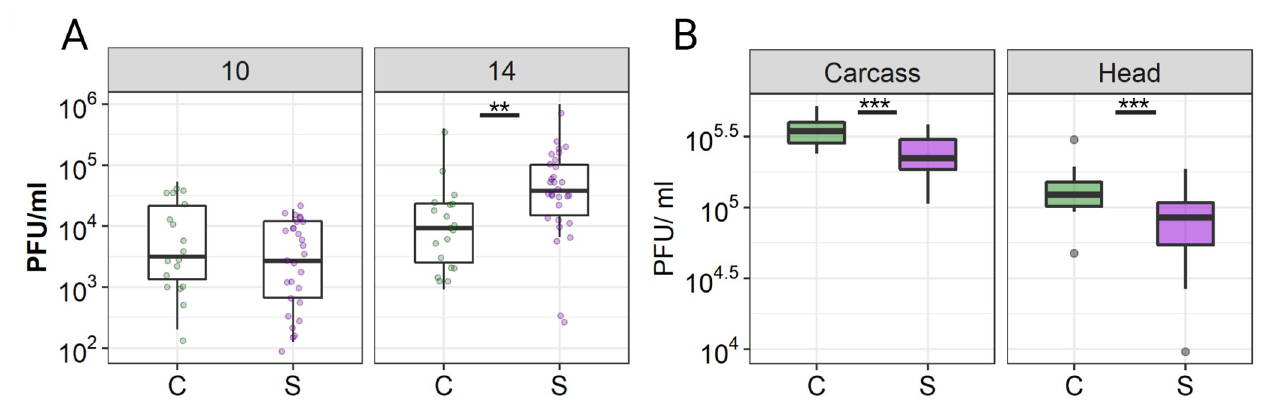
Fig 5. Dissemination and replication of ZIKV I-44 in tissue extremities of Control and Starve Ae . aegypti HWE following ingestion or intrathoracic injection of virus. (A) Starve and Control mosquitoes were fed a blood-meal containing 4.5x10 5 PFU/mL ZIKV and virus was quantified in heads at 10 days post infection (dpi) (n = 19–28 per group/timepoint) and 14 dpi (n = 21–28 per group/timepoint) by plaque assay on Vero cells. Mann-Whitney U-test was used for statistical comparison; �� = p � 0.01. Dots represent individual head tissues. ( B ) ZIKV was quantified in head tissue and carcasses of Starve and Control mosquitoes at 10 days post-intrathoracic injection of virus (around 140 PFU per mosquito; n = 20–21 per group). Outliers are shown as grey dots and were not included in the statistical analysis. T-test was used for statistical analysis ( �� = p � 0.01, ��� = p � 0.001). Boxplots represent median titre, upper and lower quartiles with whiskers showing data